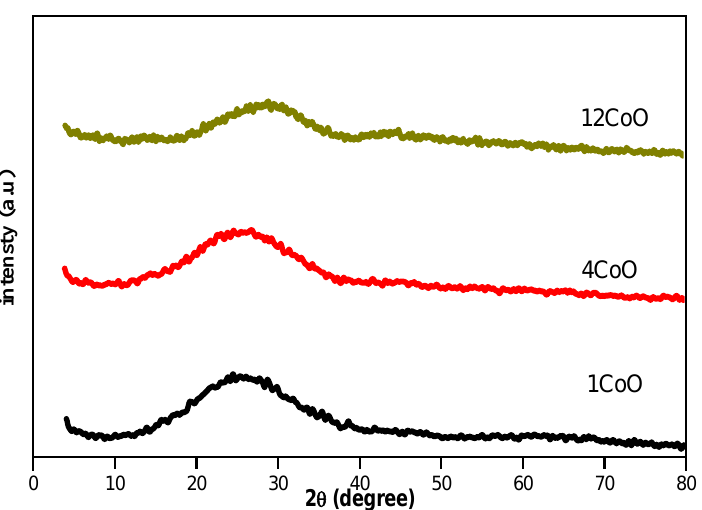
Figure 2. XRD patterns of the glasses (50 − x)P 2 O 5 –20B 2 O 3 –5Al 2 O 3 –25Na 2 O–xCoO, (x = 1, 2, 4, 8 and 12 mol%).